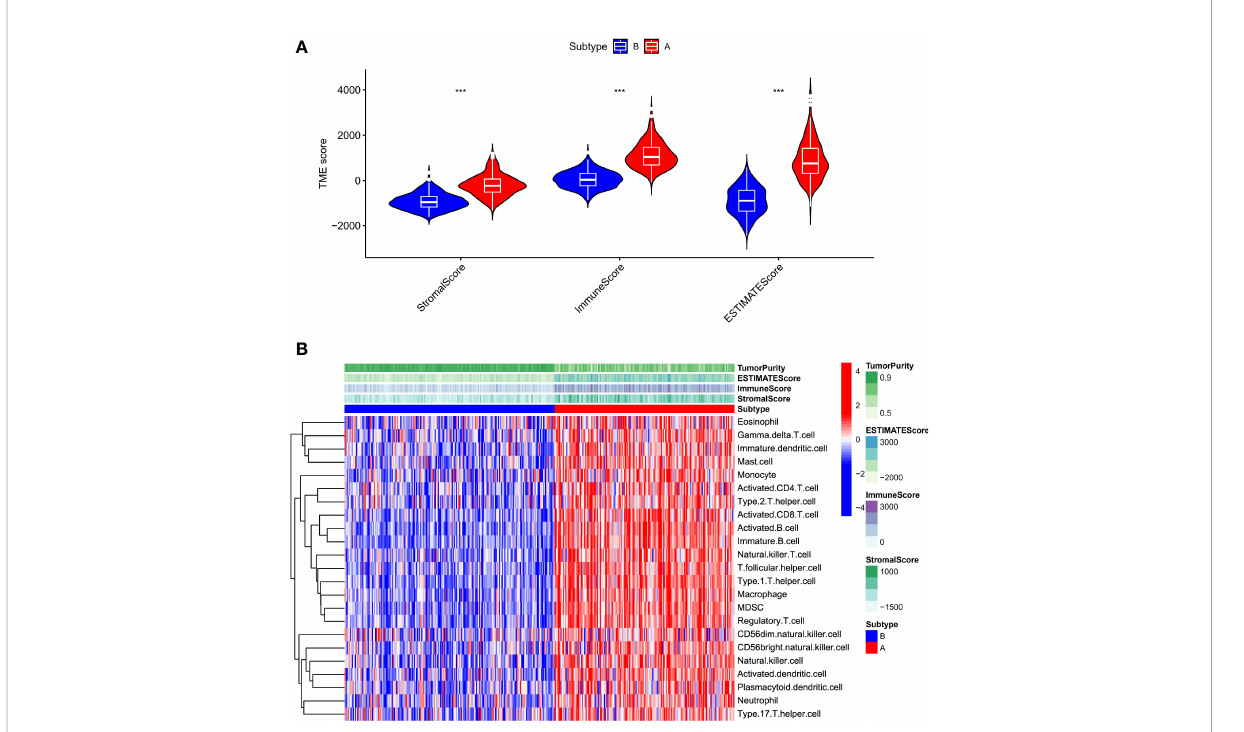
FIGURE 4 Characterization of subtype A and B HCC samples. (A) . The ESTIMATE algorithm calculates the stromal score, immune score, and estimates the score of subtype A and B HCC samples (B) . Heatmap illustrated that subtypes A and B have different immune cell in fi ltration status and tumor purity scores (***p <